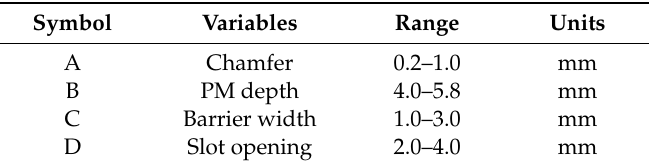
Figure 6. Design variables of full factorial design; A is Chamfer, B is PM depth, C is Barrier width, and D is Slot opening. Table 2. Ranges of design variables for FFD.